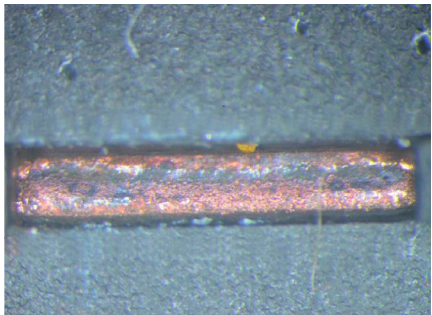
Figure 8: Fracture morphology of the pin for the semiconductor